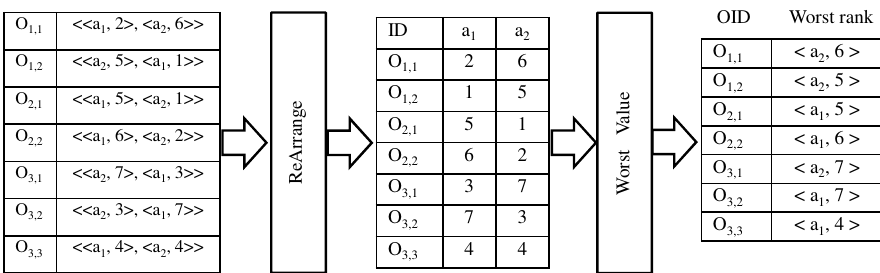
Figure 5. Worst rank computation process.